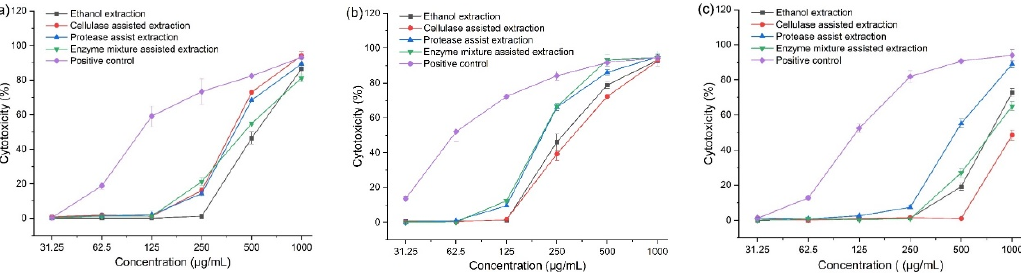
Figure 3. Cytotoxicity of corn tassel extracts by different extraction methods in Caco-2 ( a ), A549 ( b ), and Wi-38 ( c ) cell lines. Positive control—doxorubicin.